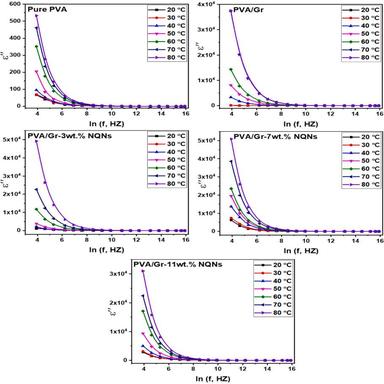
ε″ as a function of ln (f) for the pure PVA and the fabricated PNCs (PVA/Gr, PVA/Gr-3 wt% NQNs, PVA/Gr-7 wt% NQNs, and PVA/Gr-11 wt% NQNs). The measurements were conducted at temperatures (20–80 ◦C) and at different applied frequencies starting from 50 Hz up to 8 MHz.